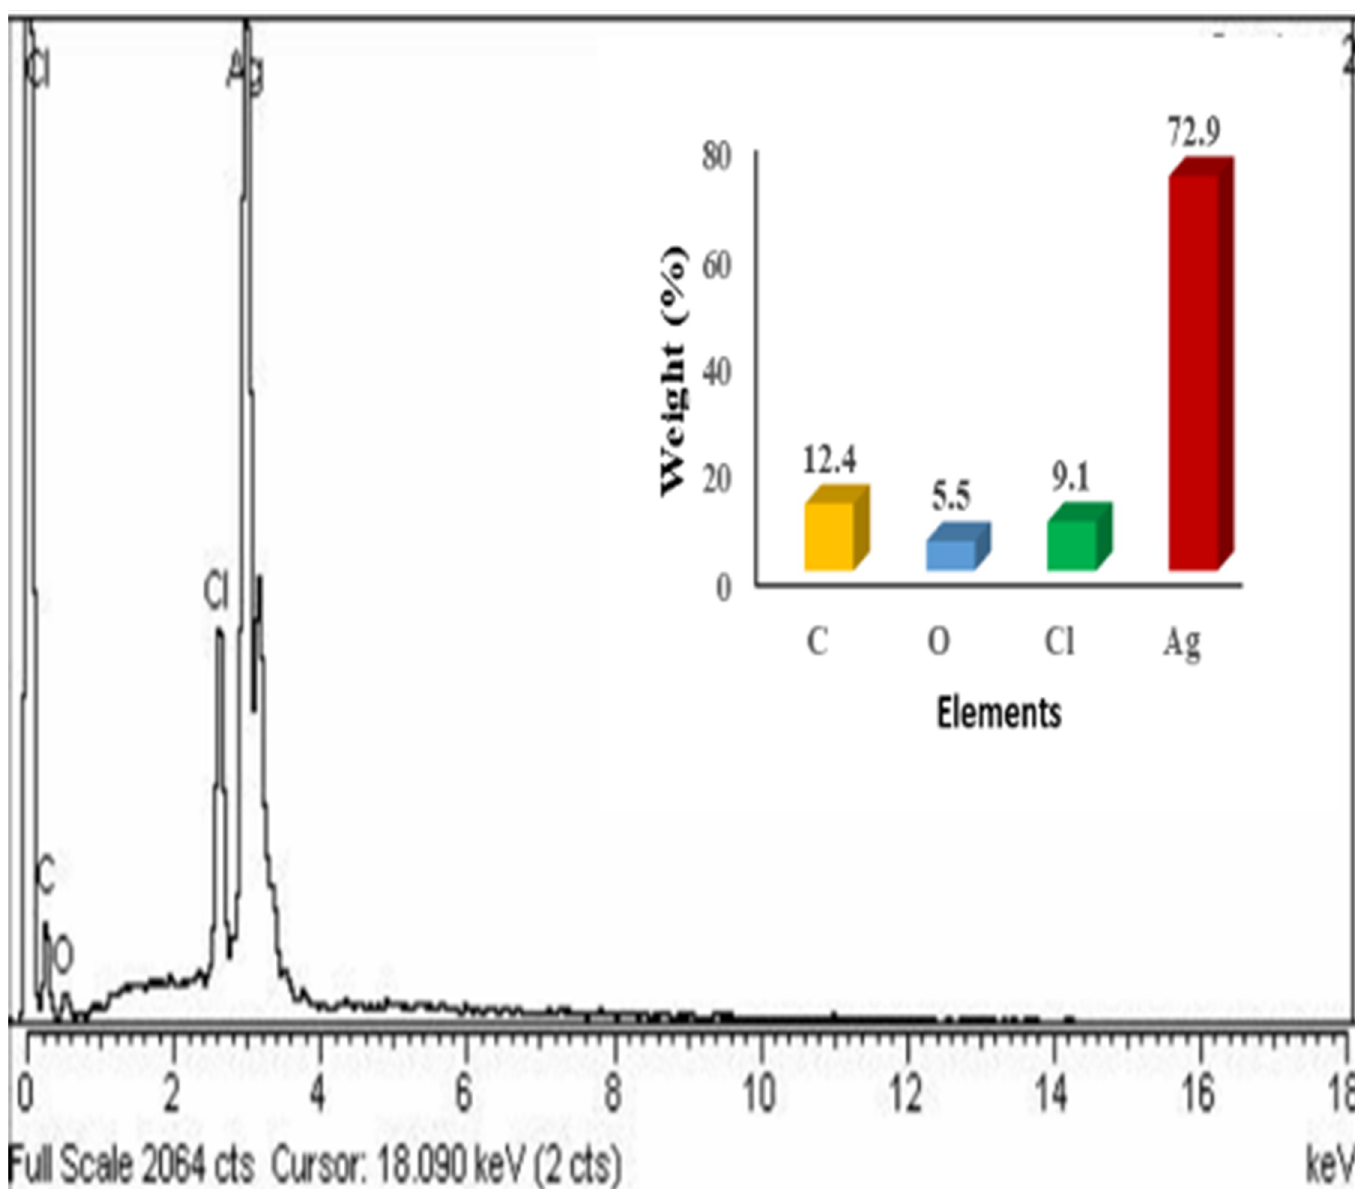
Fig 9. EDX analysis of green synthesized